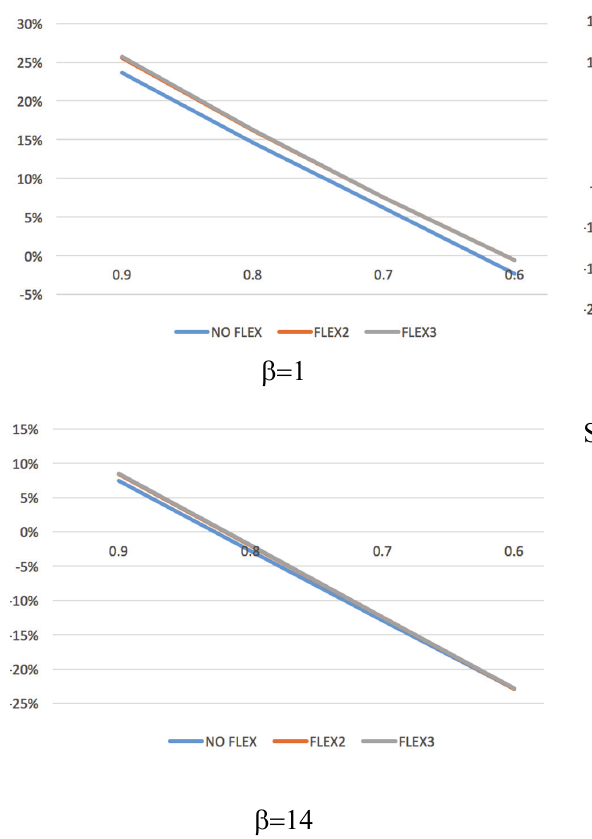
Fig. 5. Simulation results EXPO 4